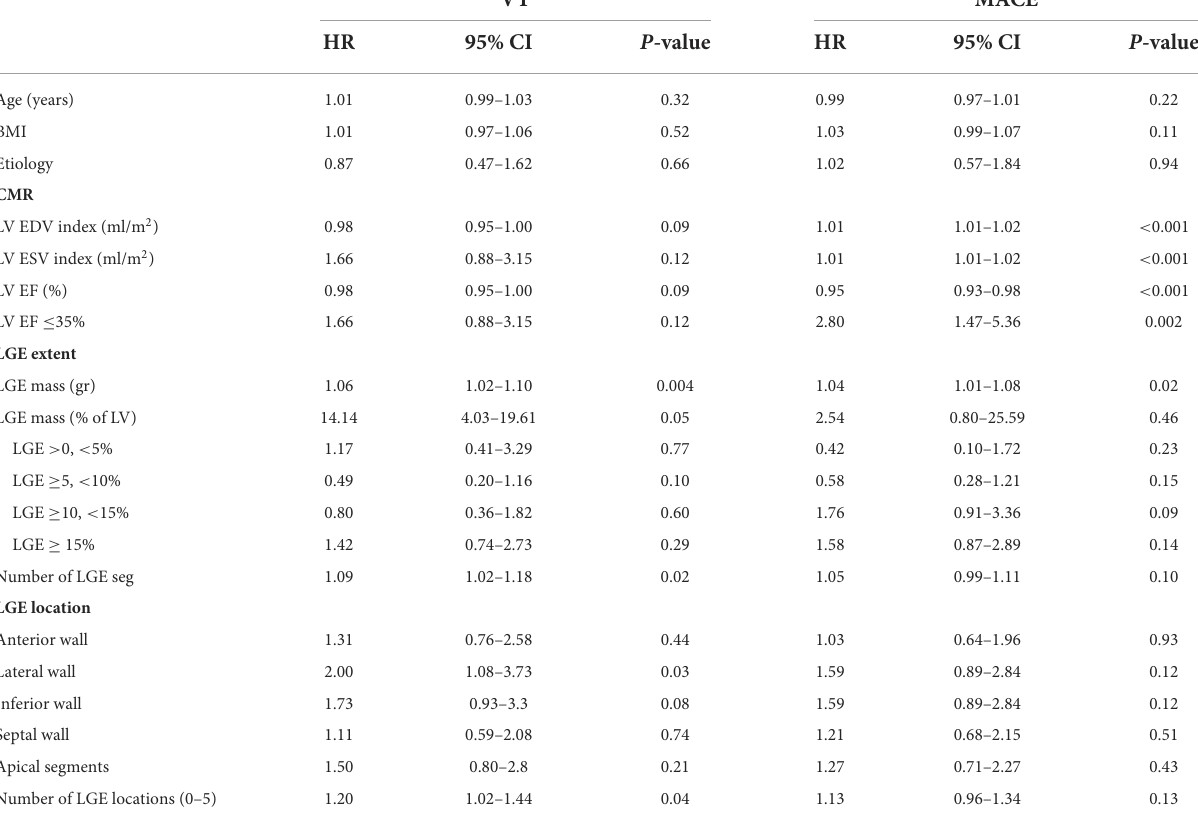
TABLE 4 Predictors of primary and secondary endpoints in the entire cohort with univariate Cox regression